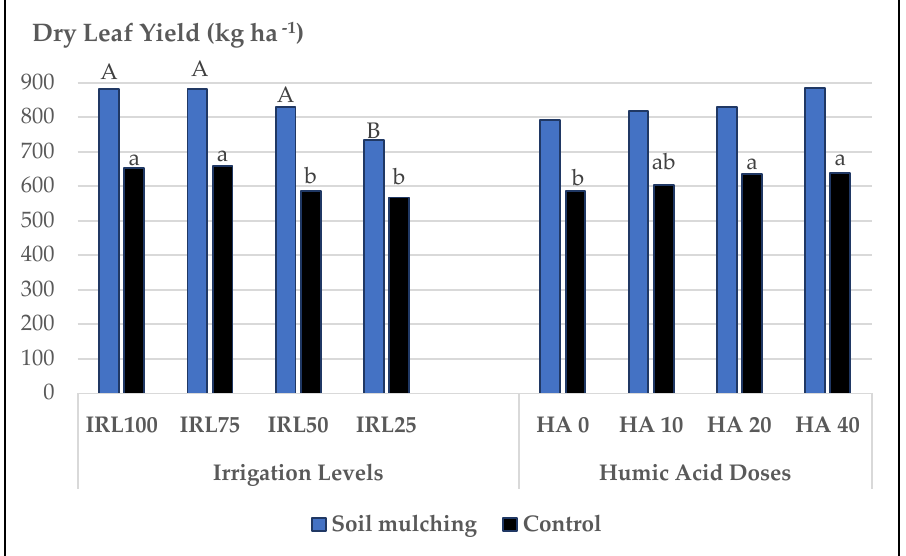
Figure 7. Mean values of DLY of O. basilicum L. under soil mulching and control conditions. IRL 100 = 100% FC; IRL 75 = 75% FC; IRL 50 = 50% FC; IRL 25 = 25% FC; HA 0 = 0.0 Lha − 1 ; HA 10 = 10.0 Lha − 1 ; HA 20 = 20.0 Lha − 1 ; HA 40 = 40.0 Lha − 1 .